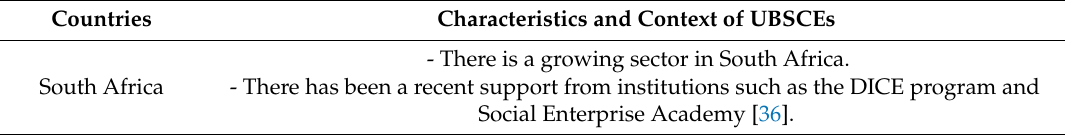
Table 2. Review of the Literature: Characteristics and context of UBSCEs in the countries selected. Countries